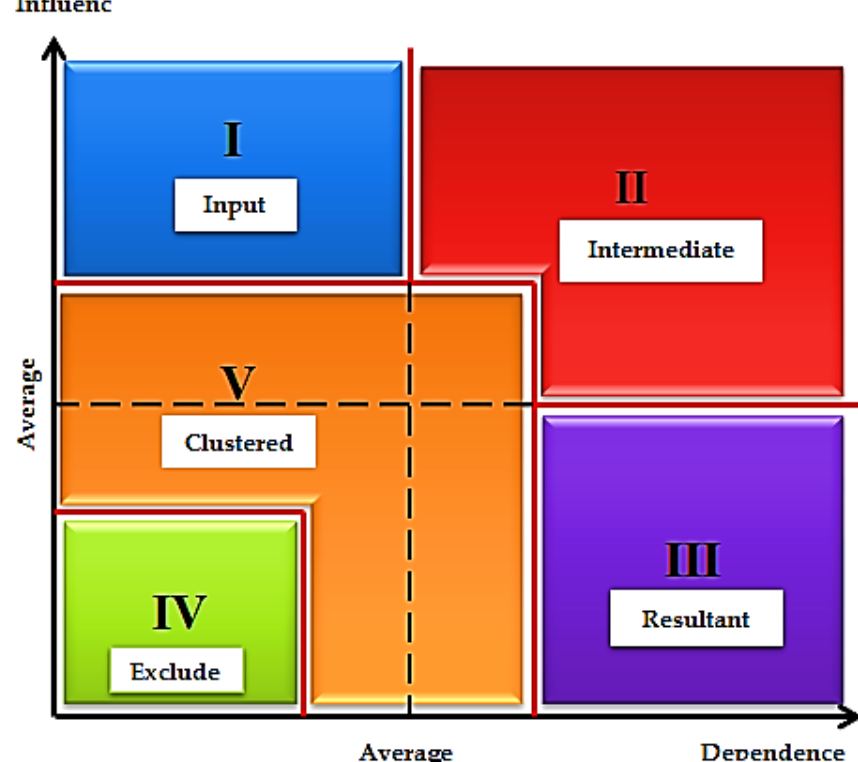
Figure 2. Different types of factors on the matrix with axes of influence and dependence.